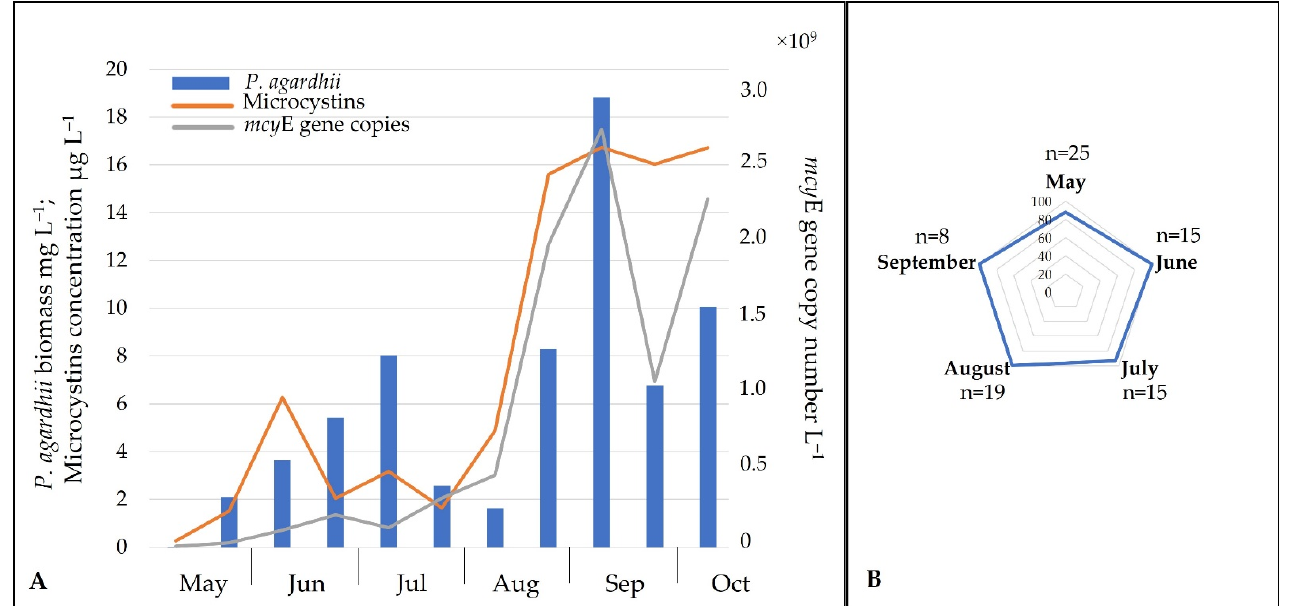
Figure 4. ( A )—Dynamics of Planktothrix agardhii (expressed by biomass), concentration of microcystins and mcy E gene copy number in the environmental samples of Lake Širvys (monodominant) in 2014. ( B )—Relative number (%) of toxigenic isolates of P . agardhii (n—number of isolates tested).